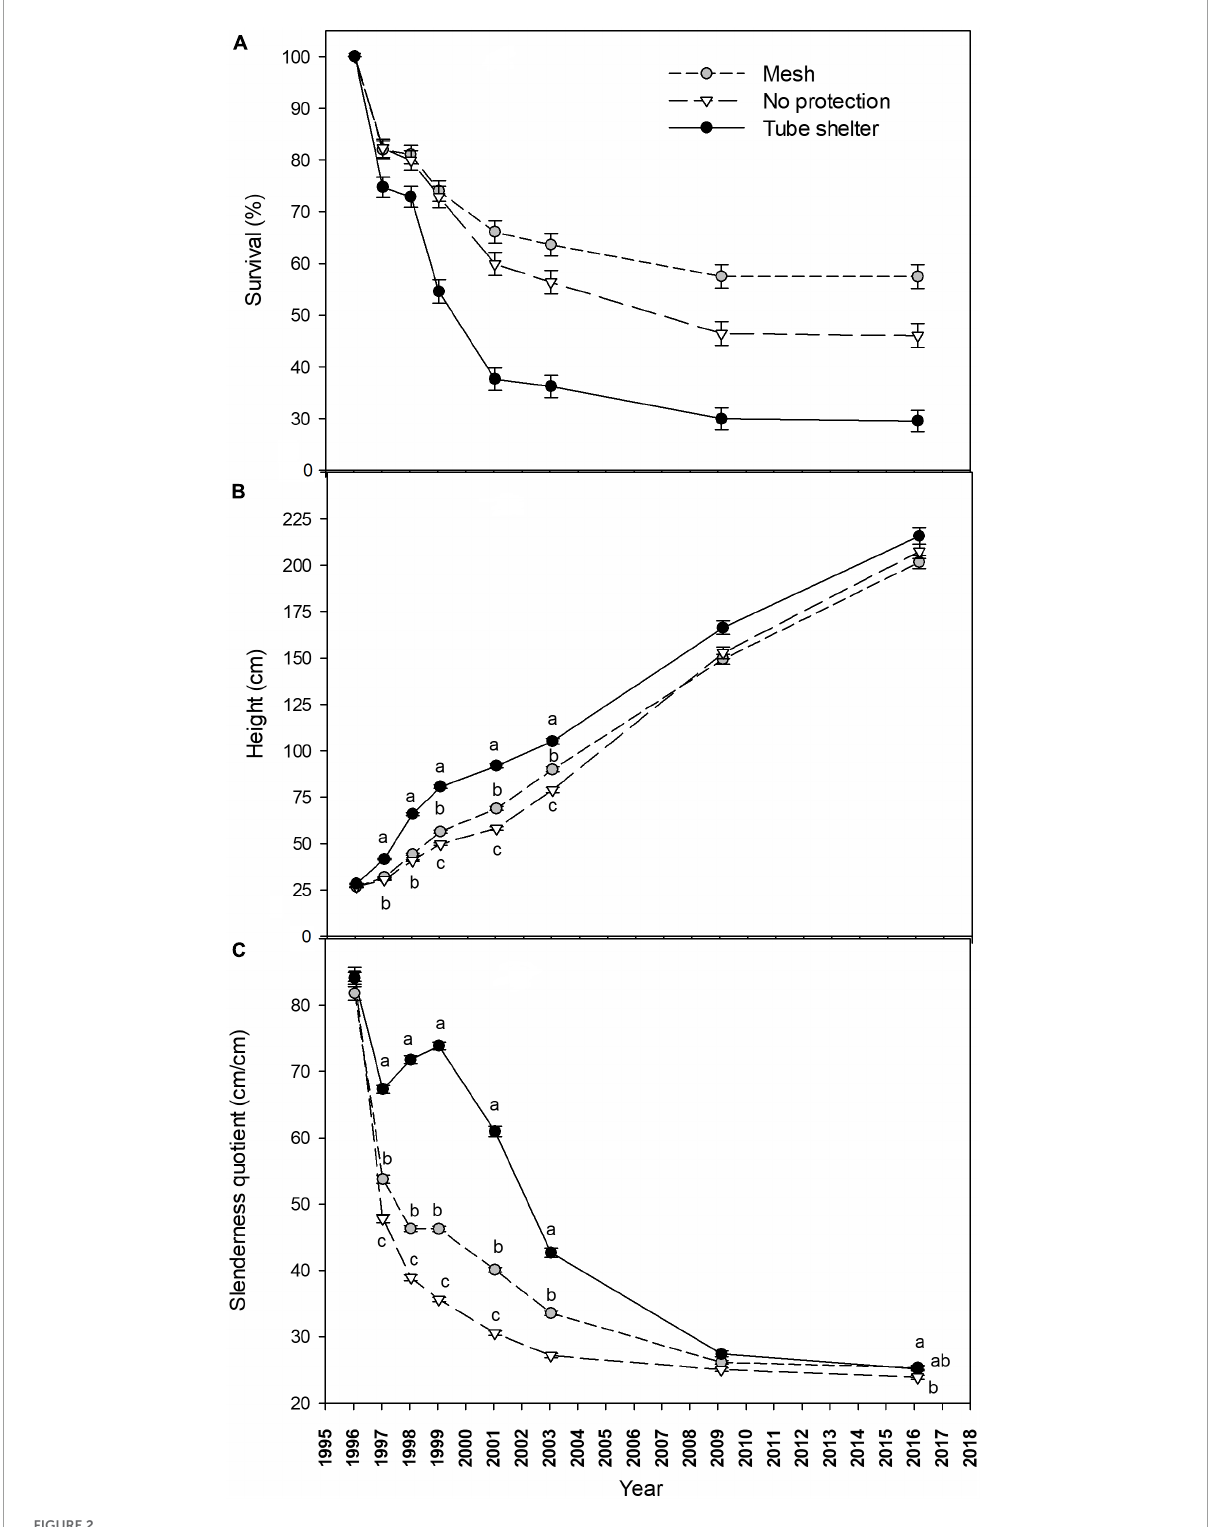
FIGURE2 Survival [ (A) %], height [ (B) cm] and slenderness quotient [ (C) cm/cm] of a Pinus halepensis plantation during a 20-year period as affected by tree shelter treatments. Depicted values are mean ± SE. Within a date, values with different lowercase letters differ significantly among tree shelter treatments according to Fisher’s protected least significant difference test, α = 0.05. In sub-figure (A) interactions with competition suppression factor preclude showing differences by tree shelters (see Supplementary Figure 2 for